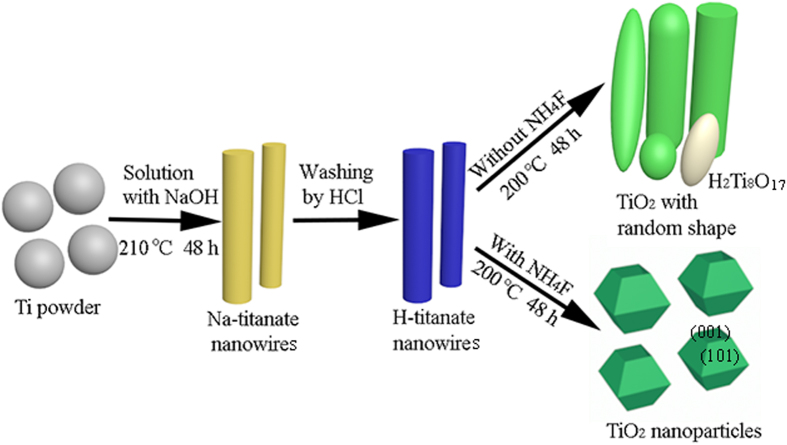
Schematic illustration of the synthetic route of TiO2.In pure water, random shape anatase TiO2 with few H2Ti8O17 and rutile TiO2 nanostrutures were formed. While in the present of NH4F, truncated octahedron TiO2 nanoparticles with exposed {001} facets were obtained.